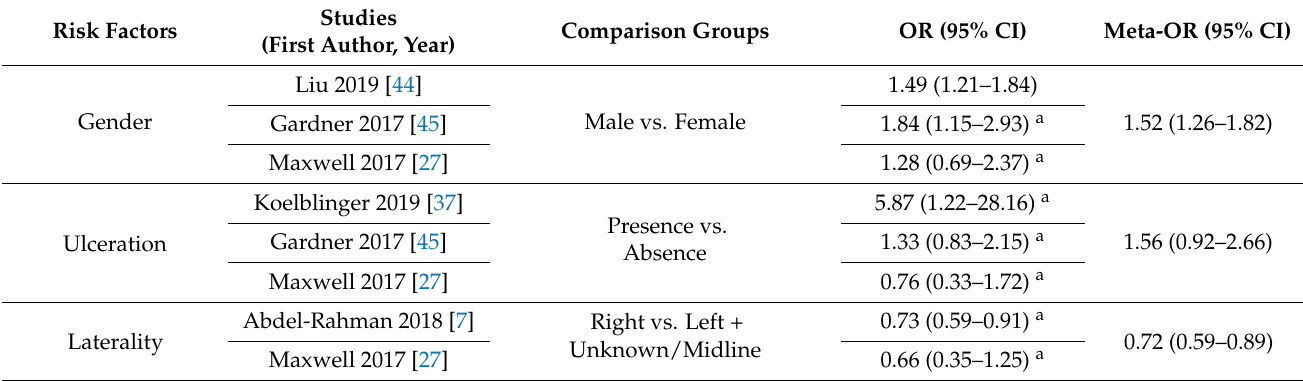
Table 3. Meta-analysis for the selected risk factors associated with MBM